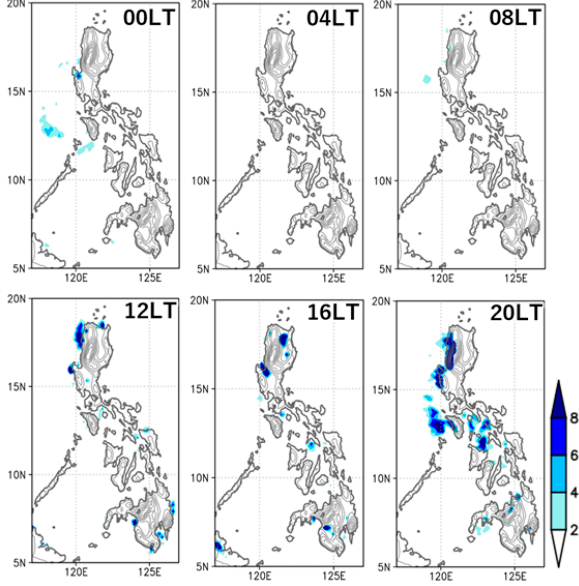
Figure 11. The same as Figure 10 but for ramp-up events.